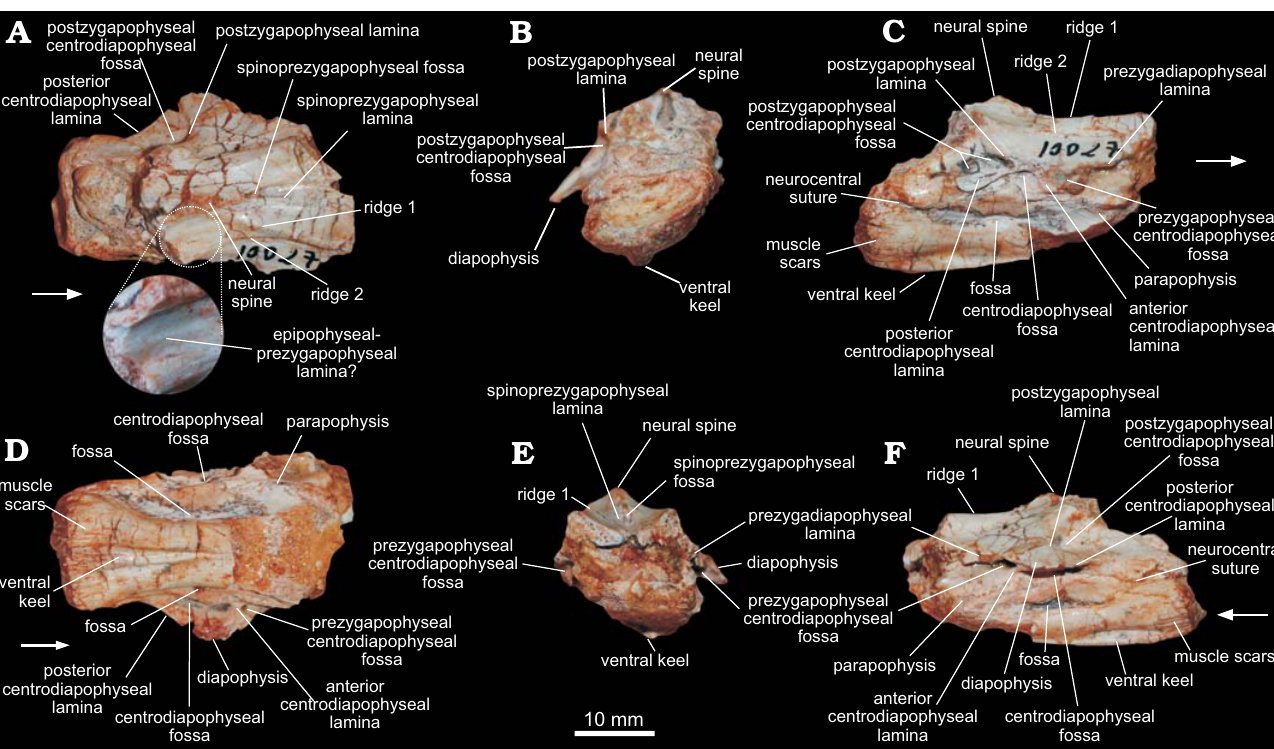
Fig. 3. Cervical vertebra of a sauropodomorph from Sacisaurus site, Late Triassic Caturrita Formation, Agudo, Rio Grande do Sul, Brazil; MCN PV 10027 in dorsal ( A ), caudal ( B ), right lateral ( C ), ventral ( D ), cranial ( E ), and left lateral ( F ) views. The zoomed area in A shows the epipophyseal-prezygapoph- yseal lamina. Arrows point to